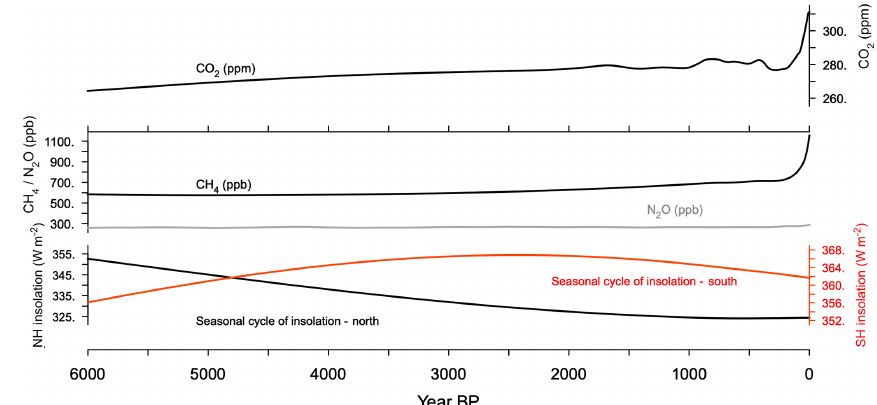
Figure 5. Evolution of trace gases CO 2 (ppm), CH 4 (ppb), and N 2 O (ppb) and seasonal amplitude (maximum annual – minimum annual monthly values) of the incoming solar radiation at the top of the atmosphere (Wm − 2 ) averaged over the Northern Hemisphere (black line) and the Southern Hemisphere (red line). These forcing factors correspond to the PMIP4 experimental design discussed by Otto-Bliesner et al.